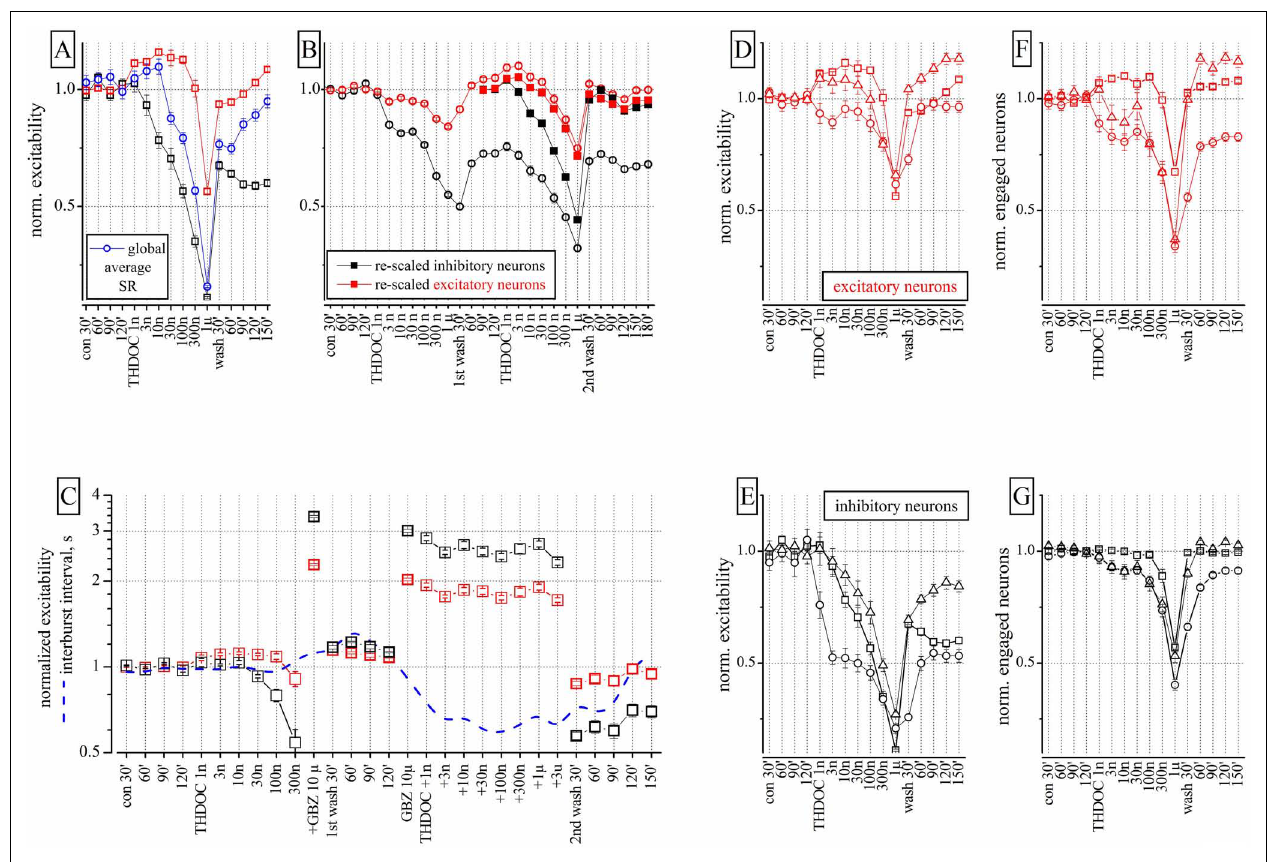
FIGURE 1 | Effects ofTHDOC on network excitability: reproducibility, action of GBZ and the plot of engaged neurons. (A) Plot of the normalized excitability of excitatory (red) and inhibitory (black) neuronal clusters in control (cont 30, 60, and 90 min), after cumulative application ofTHDOC (1 nM to 1 μ M) and after wash-out (wash 30, 60, 90, 120, and 150 min).The normalized averaged spike rate (SR: blue line) is shown in the diverse conditions and after > 2 h of wash-out; nominal mean SR for the 68 excitatory (and 13 inhibitory) exemplary neuron clusters were 0.15 ± 0.02 (1.2 ± 0.1) Hz and a total global SR of ∼ 25 Hz ( n = 81). In control, the average excitability (over 30 min) used for data normalization was for inhibitory clusters 18.9 ± 0.13 spikes/neuron ( n = 23 cells, 2 outliers) and for excitatory clusters 3.4 ± 0.03 spikes/neuron ( n = 75 cells, 11 outliers). Average inter-burst interval (IBI) was 24.2 ± 3 s. Each concentration point is the averaged excitability recorded in a 600-s time segment. (B) Data from an experiment in whichTHDOC was applied in sequence two times after a 120-min wash and after the second wash-out of 3 h. Closed symbol data are the open symbol data but re-scaled to 1 under